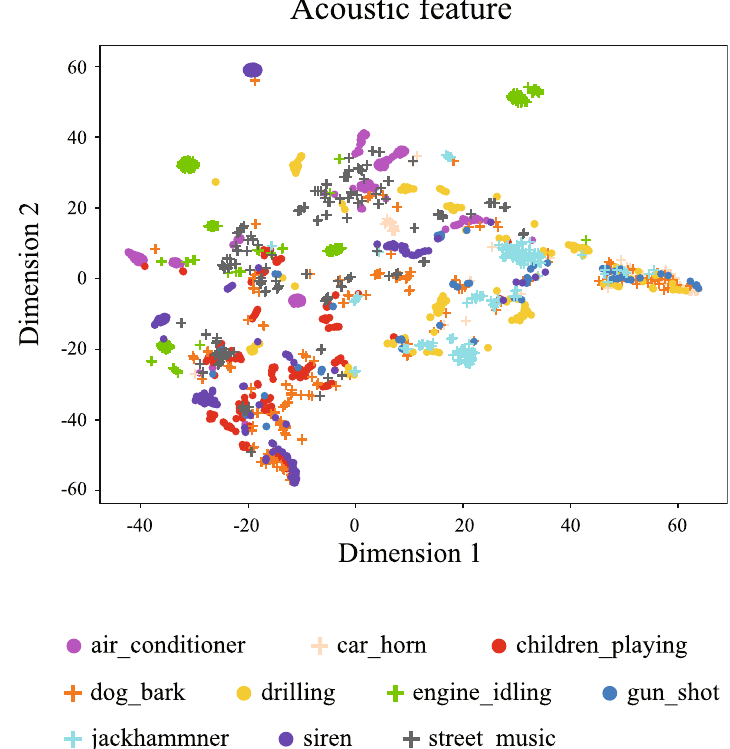
Fig. 6 Relationship among event classes on test set of UrbanSound8k in terms of acoustic features visualized using